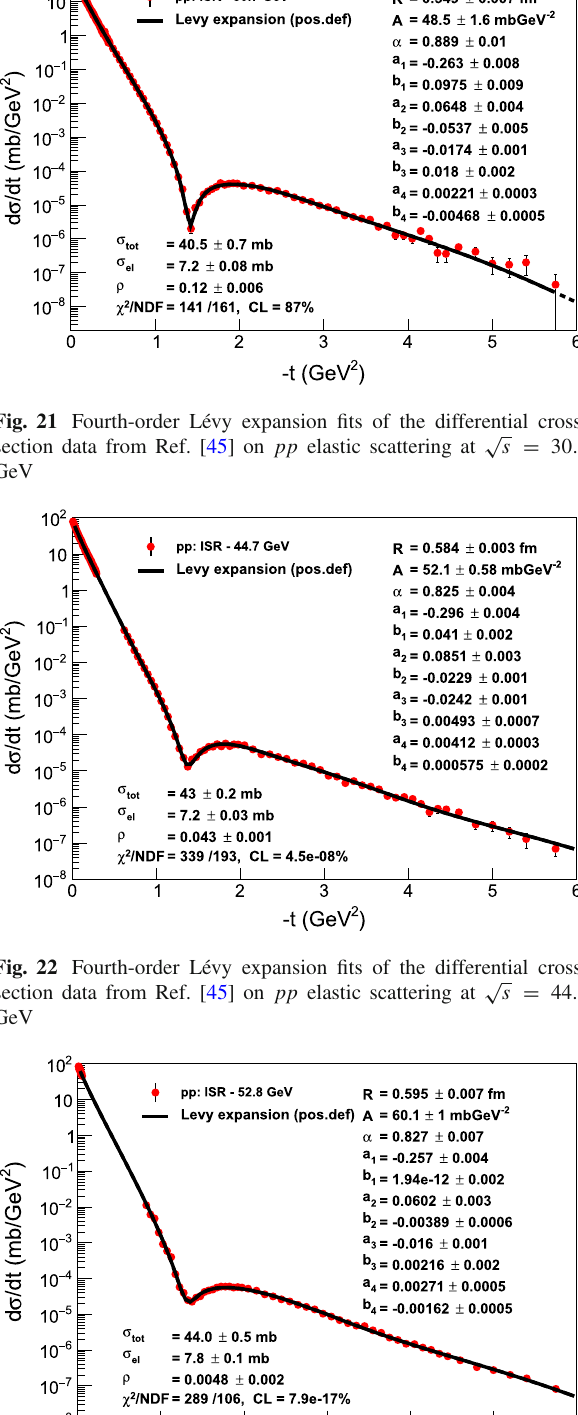
Fig. 23 Fourth-order Lévy expansion fits of the differential cross- section data from Ref. [45] on pp elastic scattering at √ s = 23 . 5